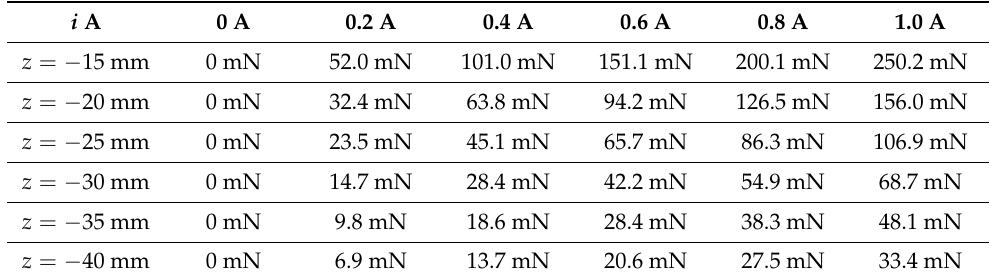
Table 1. Magnetic force F m in millinewtons [ mN ] in relationship to the current i in Amperes [ A ] and the permanent magnet position z in millimeters [ mm ]